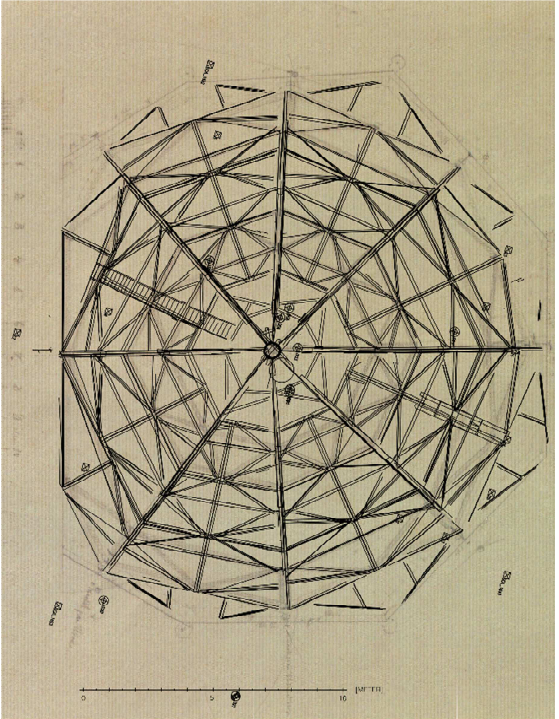
Figure 6. Superposition of the tacheometrical measurement